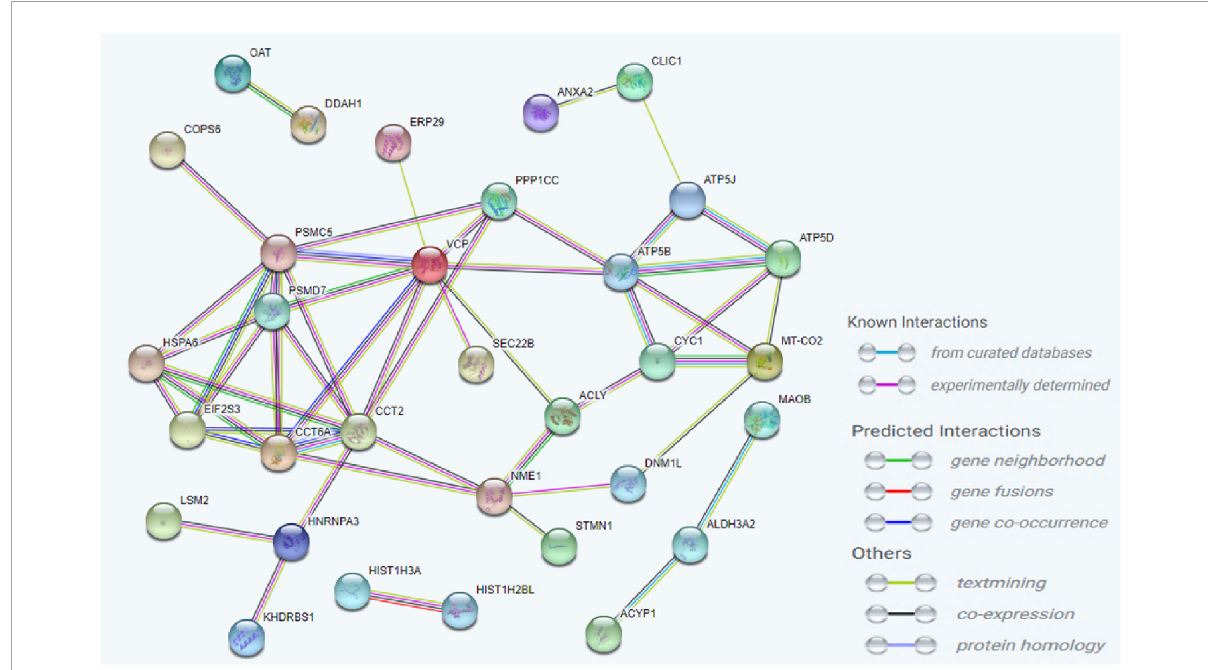
FIGURE5 Analysis of the interaction network of the most significantly altered proteins between complementary-determining region 2 (CDR2)-treated and untreated retinal explants ( p < 0.05). The STRING functional protein association network was used for the protein-protein interaction analysis. The chromatin-associated protein HIST1H2BL was identified as a reliable interaction partner of CDR2-specific target protein